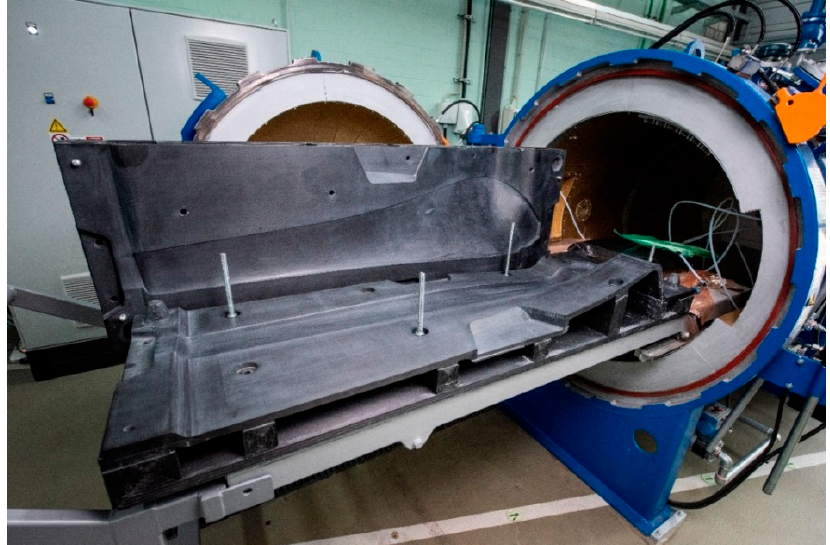
Figure 6. Direct rotorblade mold, made with LSAM technology.